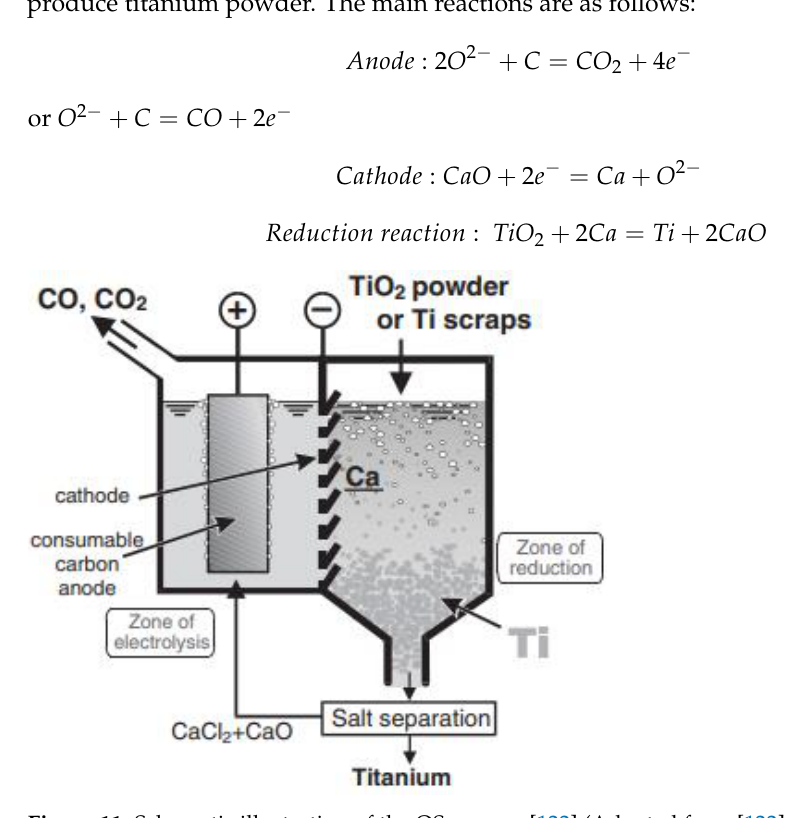
Figure 11. Schematic illustration of the OS process [122] (Adapted from [122], with permission from The Japan Institute of Metals and Materials, 2004).